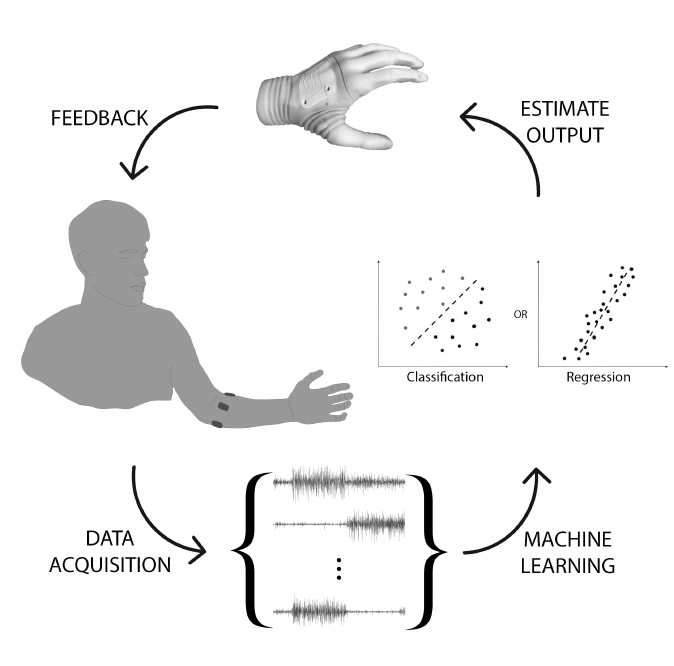
Figure 1. Closed loop for prosthetic myoelectric control. First step, acquisition of multiple EMG channels from upper limb muscles. Second, mapping into control signals with machine learning techniques (classification or regression) using the EMG features as inputs. Third, model estimation of the prosthesis output for control, and last, feedback to the user from the prosthesis (or other output